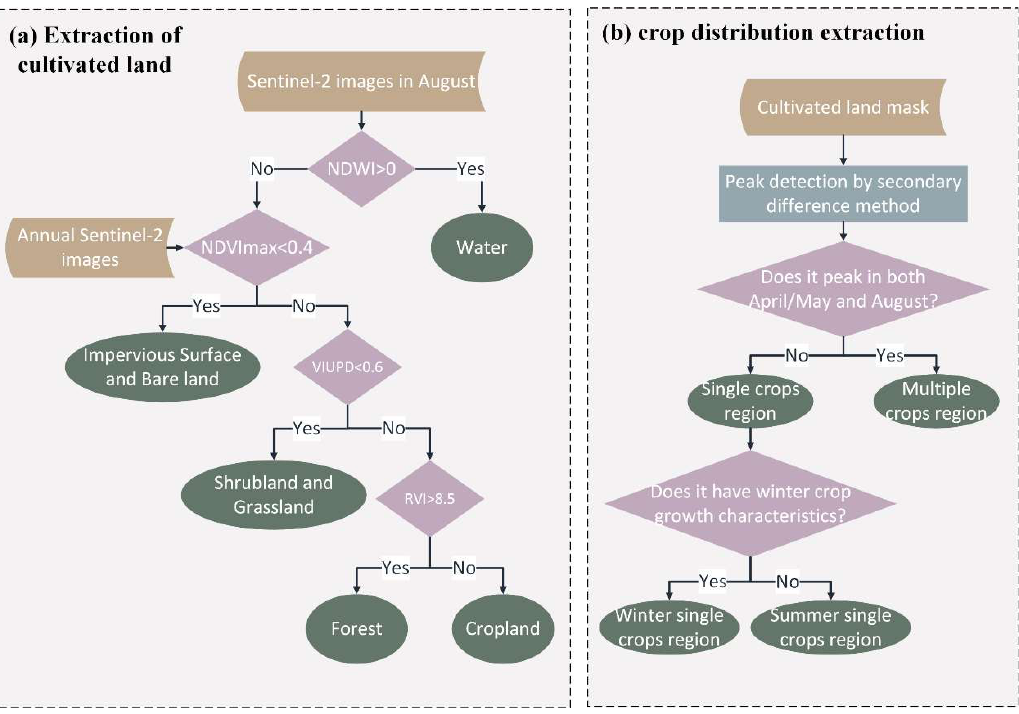
Figure 7. ( a ) Extraction of cultivated land using a classification decision tree method. ( b ) Flow chart depicting crop information extraction. Table 2. Spectral indices used in this study.